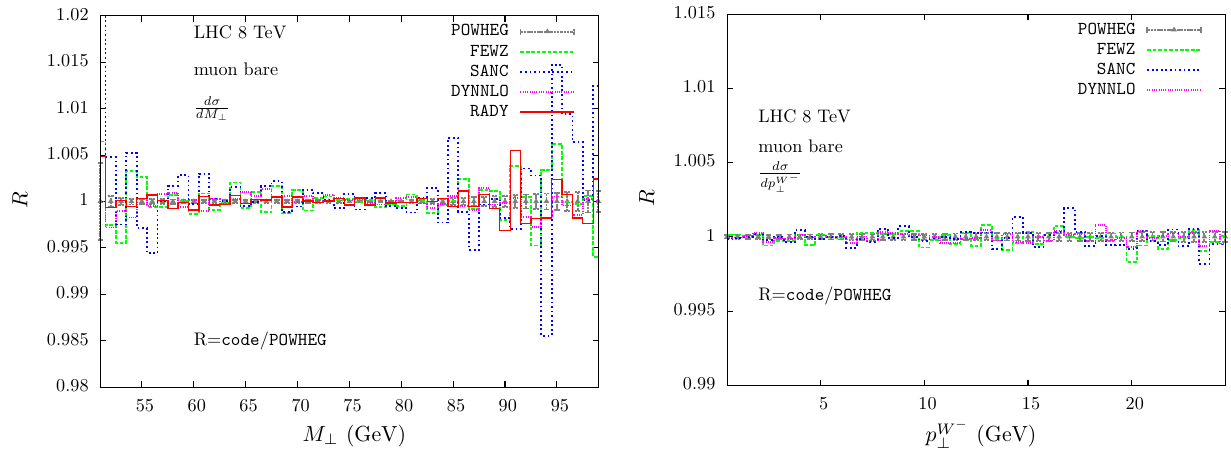
Fig. 8 Tuned comparison of the lepton-pair transverse mass and transverse momentum distribution in pp → W − → μ − ¯ ν μ + X at the 8 TeV LHC with ATLAS/CMS cuts in the bare setup, including NLO QCD